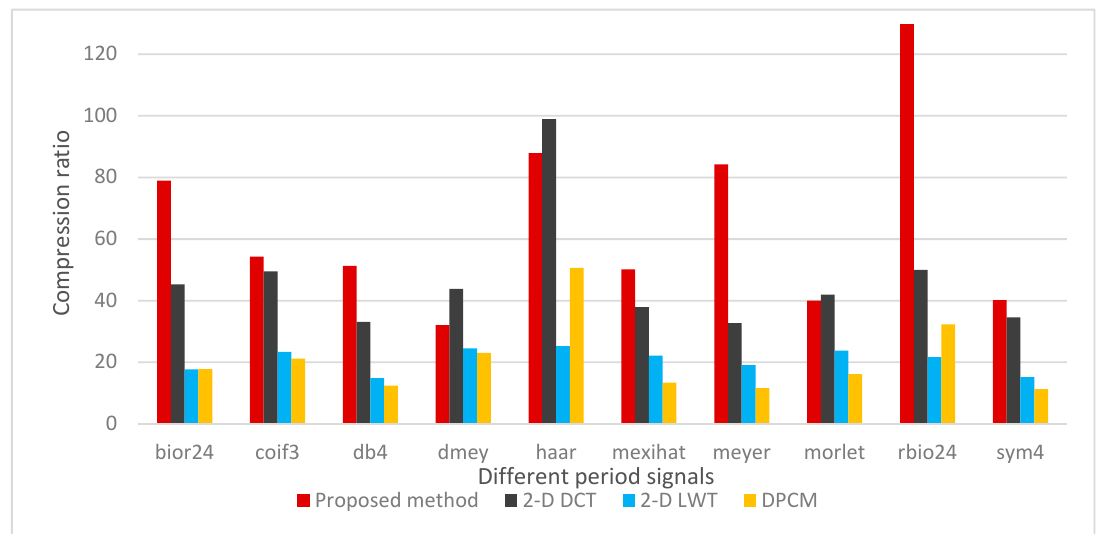
Figure 11. Comparison of the compression ratio of the signal compression by LZW. Table 2. Comparison of the compression ratio of the methods proposed in this paper with 2-D DCT, 2-D LWT, and DPCM.